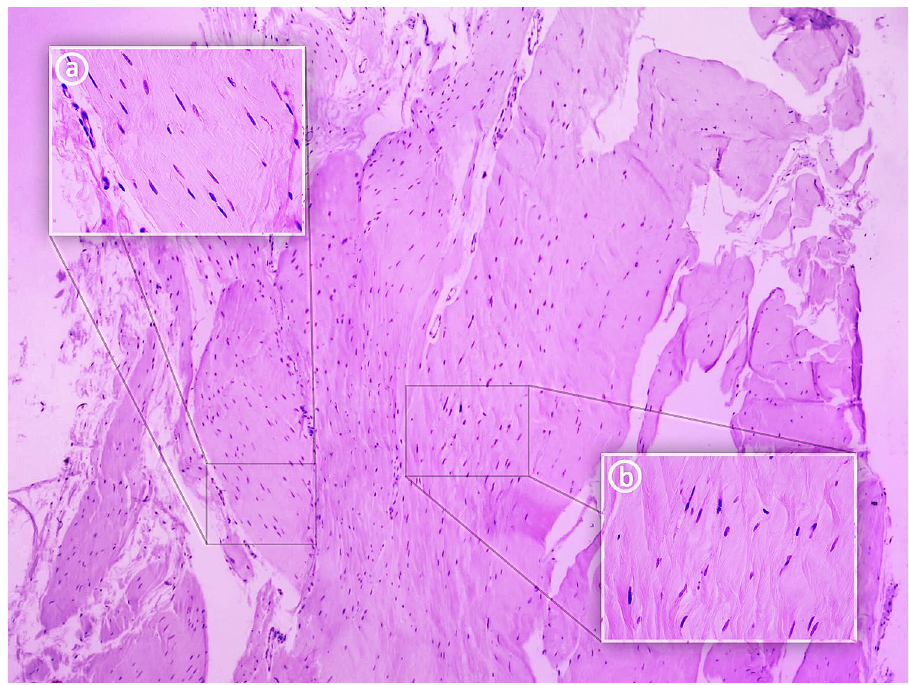
Figure 3. Histological examination of the plantaris ligamentous tendon. ( a ) 400 × magnification—tendon; ( b ) 400 ×